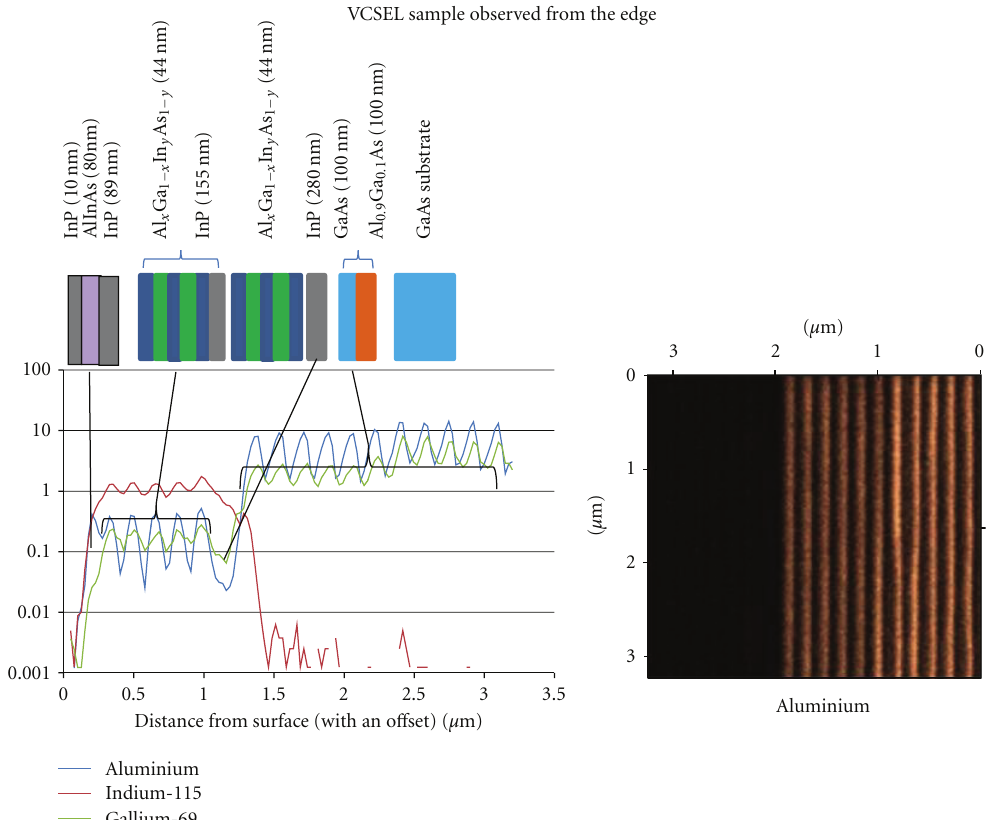
Figure 13: Side-on view of VECSEL 3/1 (see text). As for the depth profile, all features can be discerned, expect for the structure within each quantum well gain region (each 44nm thick containing three 10nm bands richer in aluminium). The 100 nm thick aluminium rich regions in the distributed Bragg reflector (right-hand side of figure and image) are well separated but do not have a flat-top. The lateral resolution is thus of the order of 100 nm in this example.